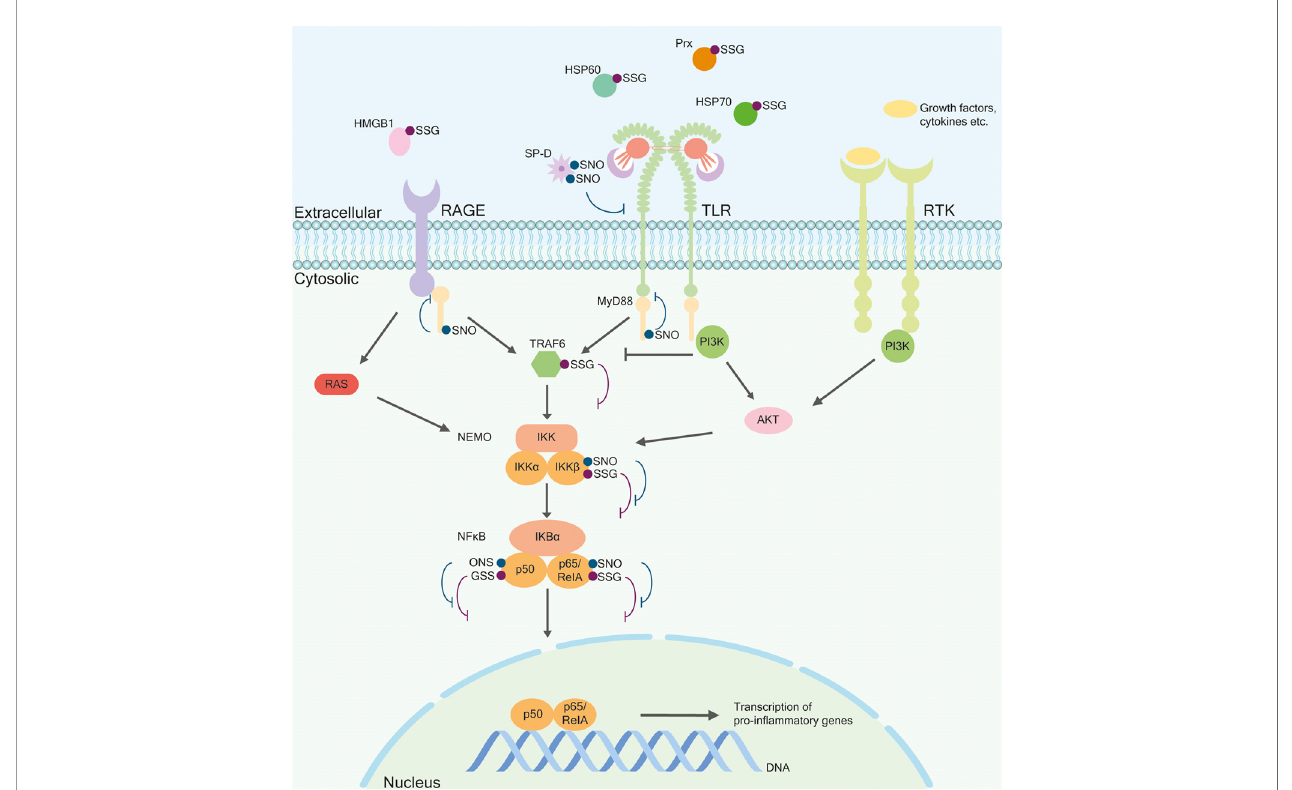
FIGURE 1 | Selected thiol modi fi cations in the regulation of the in fl ammatory response. Posttranslational modi fi cations such as S-glutathionylation and S- nitrosylation occur on intracellular and extracellular proteins. Many ligands for membrane-bound receptors such as receptors for advanced glycation end products (RAGE), Toll-like receptor (TLR), and receptor tyrosine kinase (RTK) undergo redox regulation. Nitrosylated, oligomeric Surfactant protein D (SP-D) binds and inhibits TLR. Heat shock proteins (HSPs) 60 and 70, High-mobility group box 1 (HMGB1), and Peroxiredoxin (Prx) are glutathionylated. They bind to RAGE or TLR, inducing similar downstream-signaling components Tumor necrosis factor receptor – associated factor (TRAF), Nuclear Factor-kappa-B essential modulator (NEMO), Nuclear Factor-kappa-B (NF k B) and eventually a pro-in fl ammatory response. The RAGE receptor can also activate the NEMO complex via RAS. Also, the TLR pathway can be activated through the Phosphoinositide 3-kinases (PI3K) pathway. PI3K binds to the receptor, which inhibits TRAF6 and activates the serine/threonine-protein kinases (Akt) pathway by activating NEMO. Different components of this pathway can be glutathionylated or nitrosylated. Nitrosylated myeloid differentiation primary response 88 (MyD88) leads to the detaching of the receptor whereby the signal is inhibited. Nitrosylated or glutathionylated IKK b , p50, and ReIA/p65 lead to their inactivation, eventually inhibiting gene